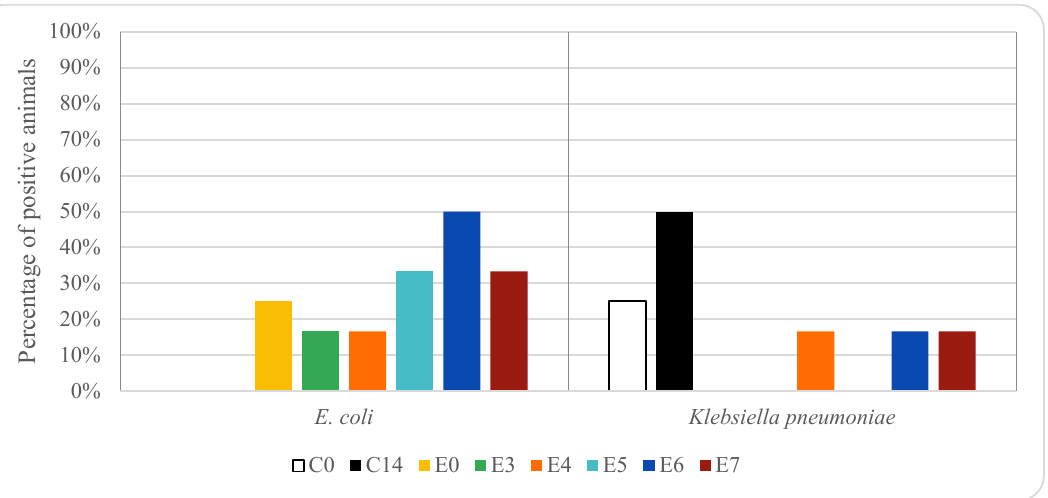
Figure 5. Effect of oxytetracycline treatment on ESBL-producing E. coli and K. pneumoniae in pig rectal samples. For group descriptions, C0, C14, T0, T6, T13, T15, T17 and T19: see Table 1.